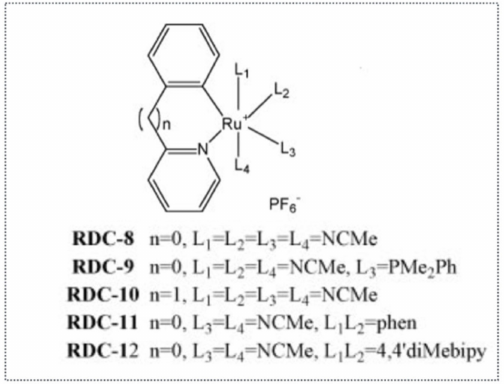
Figure 3. Examples of ruthenium organometallic complexes that induce the ER stress pathway. First generation RDC synthesized by the Dr. M. Pfeffer’s team and tested for their biological